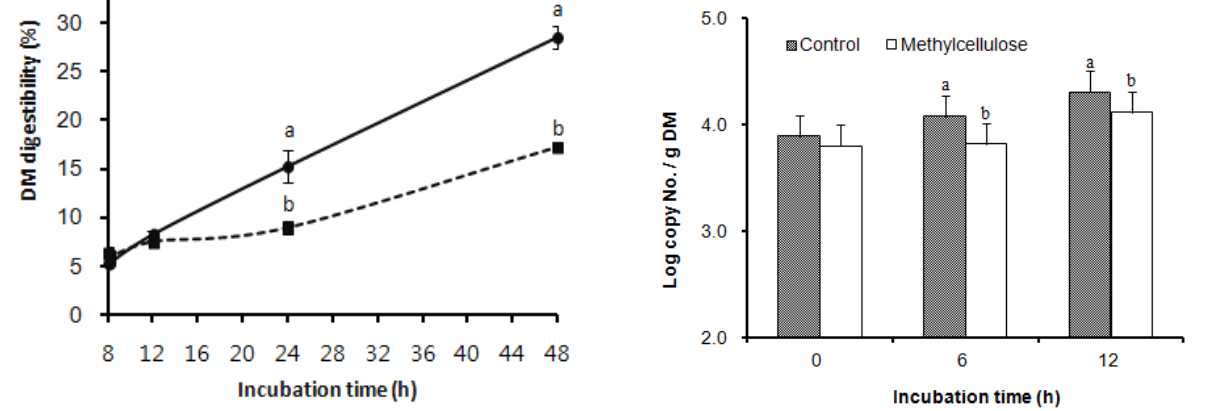
Figure 6. Attachment of Fibrobacter succinogenes as influenced by rice straw pre-treatment with MC (methylcellulose). a,b Means with different letters differ significantly